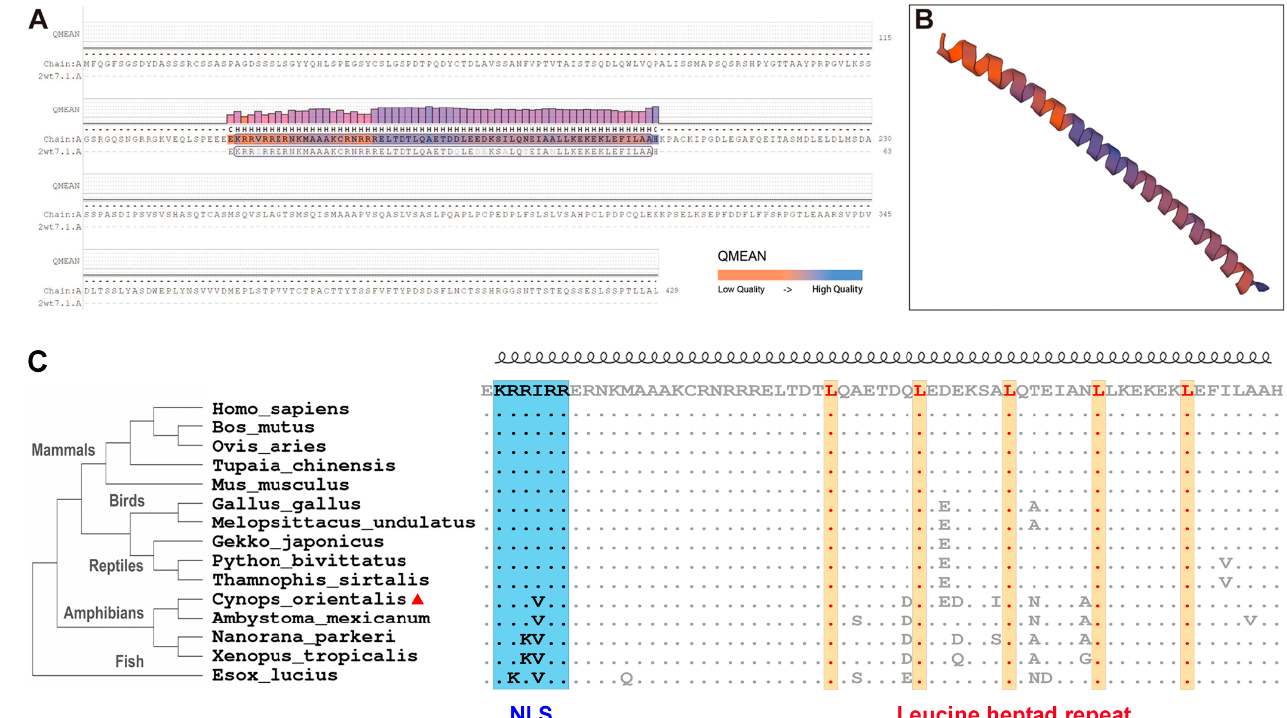
Figure 1. Protein structure homology modeling and phylogenetic reconstruction of Co-c-Fos . ( A ) Target–template alignment. The QMEAN Z-score indicates model quality and is visualized by using bar plots and a color scheme. ( B ) The predicted secondary structure exhibits continuous α -helices, which are displayed in a three-dimensional view. ( C ) Multiple sequence alignment and phylogenetic analysis of the bZIP domain among vertebrates. The reference sequence corresponds to the human bZIP domain. The predicted NLS (nuclear localization sequence) is shaped in blue, and the heptad-repeat leucines are highlighted in yellow.